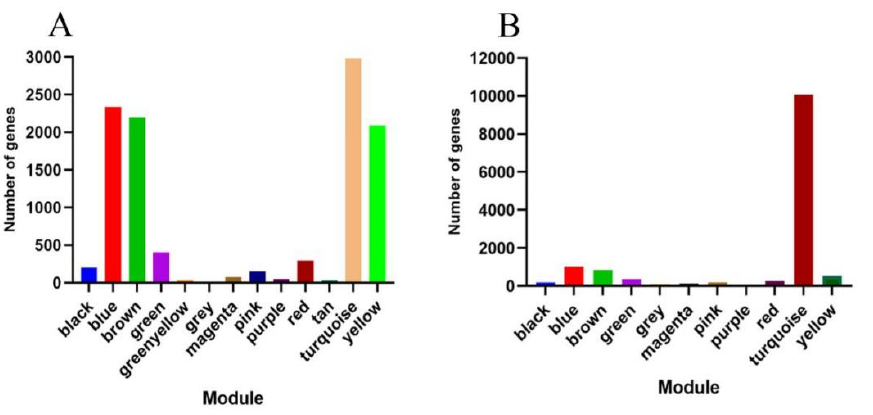
Figure 8. Genes included in different modules: ( A ) Xinluzao 50 and Xinluzao 50 FLM; ( B ) CSS386 and Sicala V-2.